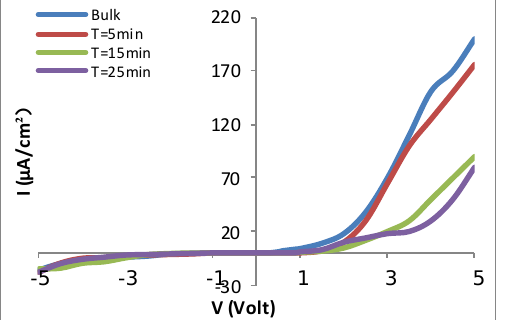
Figure 4: J-V characteristics Si/PS Al prepared with etching time 5, 15, 25 min. etching current density, 20 mA/cm² at HF concentration